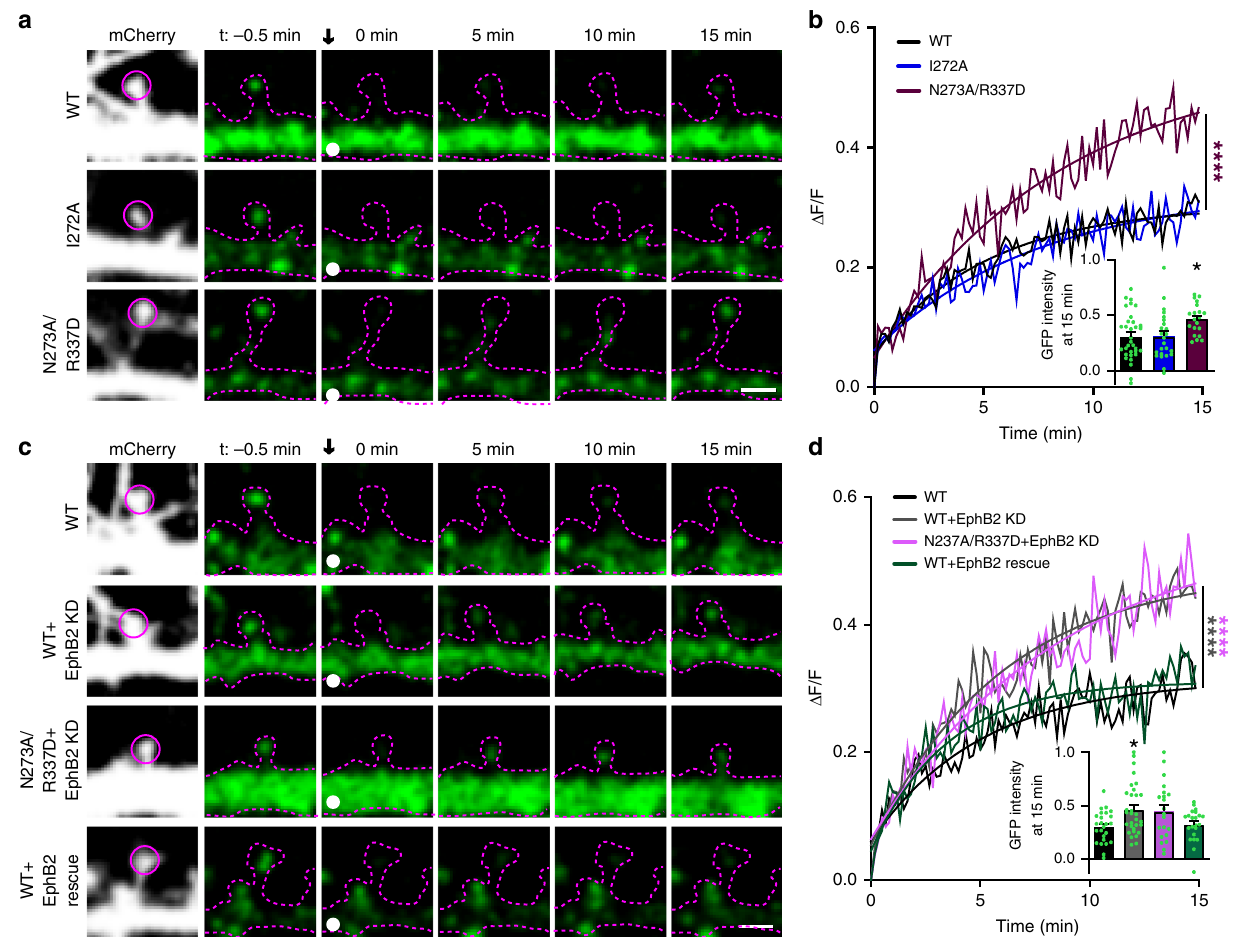
Fig. 8 GluN1 charge mutants show increased mobility due to disrupted EphB – NMDAR interaction. a Representative FRAP images at different time points of DIV21 – 23 cortical neurons transfected with EGFP – GluN1 (WT, I272A, or N273A/R337D) together with GluN2B, CRISPR construct targeting endogenous GluN1, and mCherry. Recovery of bleached spine puncta (magenta circle) was monitored for 15 min at 10s intervals. Scale bar = 2 µ m. b Quanti fi cation of the recovery curve of different GluN1 mutants in DIV21 – 23 cortical neurons. Graphs represent mean intensity and show fi t (**** p < 0.0001, Kolmogorov – Smirnov (KS) nonparametric test). Inset: Quanti fi cation of the mobile fraction of EGFP – GluN1 spine puncta at 15 min after photobleaching